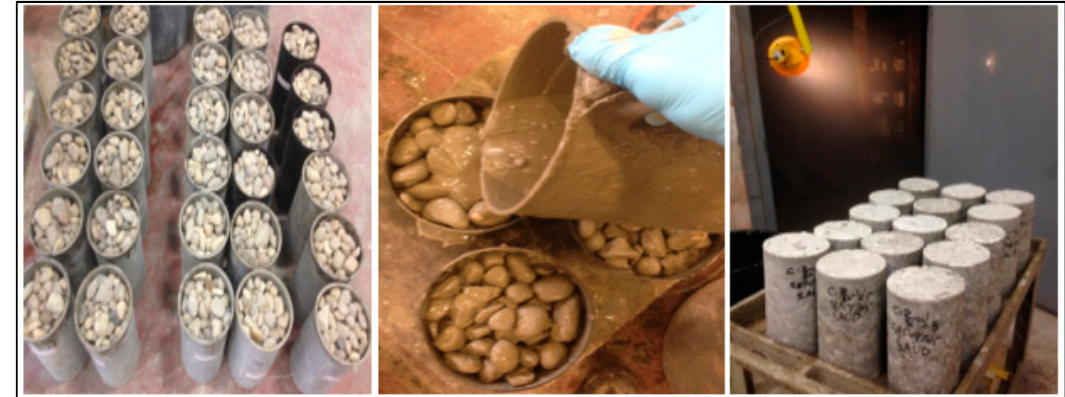
Figure 2. TSC specimen preparation showing preplaced aggregates in cylindrical molds ( left ), Figure2. TSCspecimenpreparationshowingpreplacedaggregatesincylindricalmolds( left ), placement placement of grout by gravity ( center ) and final demolded specimens ( right ). of grout by gravity ( center ) and final demolded specimens ( right